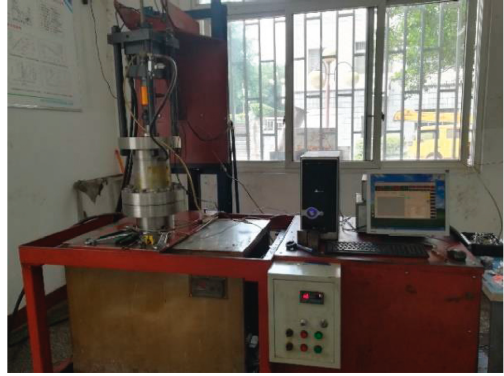
Figure 1: Triaxial servo-controlled seepage equipment for hot- fluid-solid coupling of coal containing